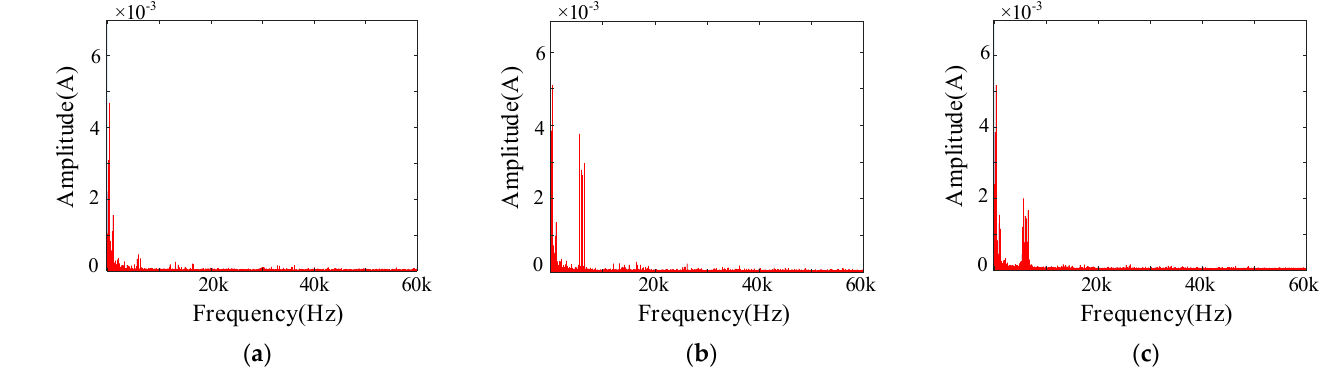
Figure 13. Experimental frequency spectrum of the output voltage and the circulating current when ( a ) θ = 0, ( b ) θ = π / N or ( c ) SDA-based CPS modulation is adopted.